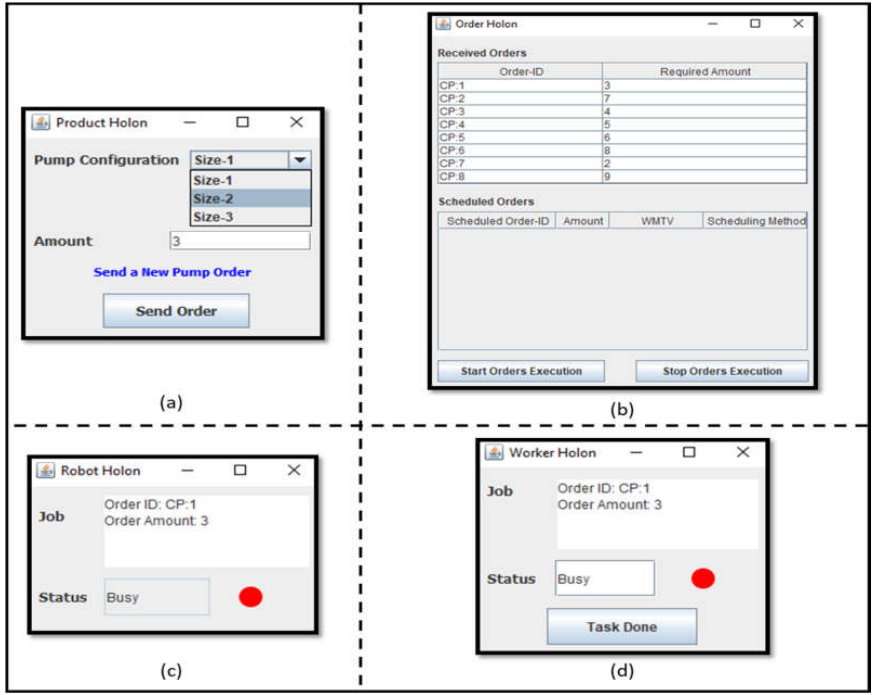
Figure 6. ( a ) Product Holon Interface; ( b ) Order Holon Interface; ( c ) Robot Holon Interface; ( d ) Worker Holon Interface.